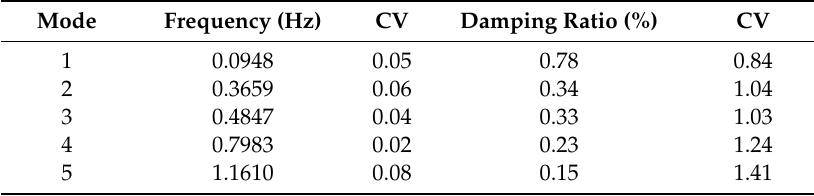
Figure 10. TF planes for the acceleration signal in the short-axis direction of Canton tower obtained by: ( a ) EWT; ( b ) SWT; ( c ) EMD. Table 2. Modal parameters identified from signal mono-components of Canton